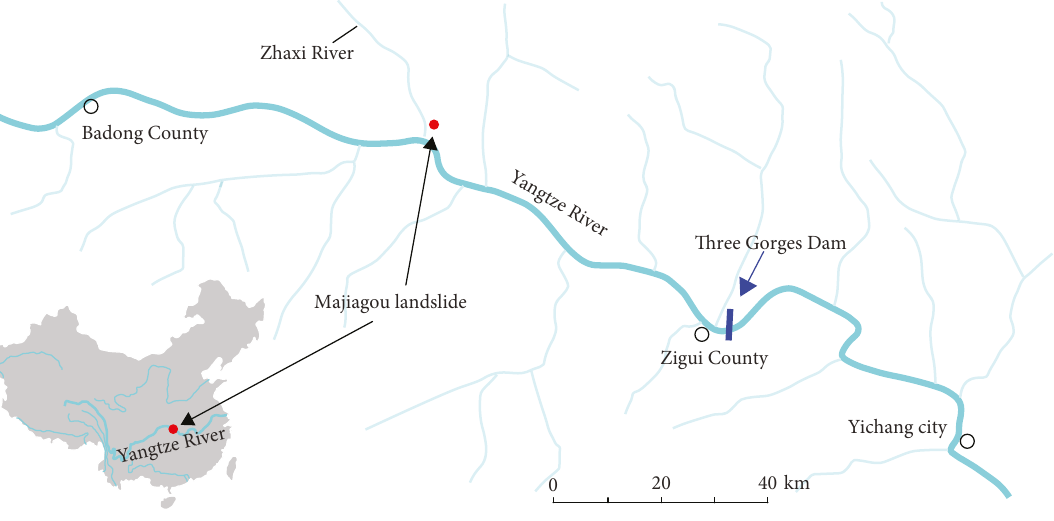
Figure 1: Location of the Majiagou